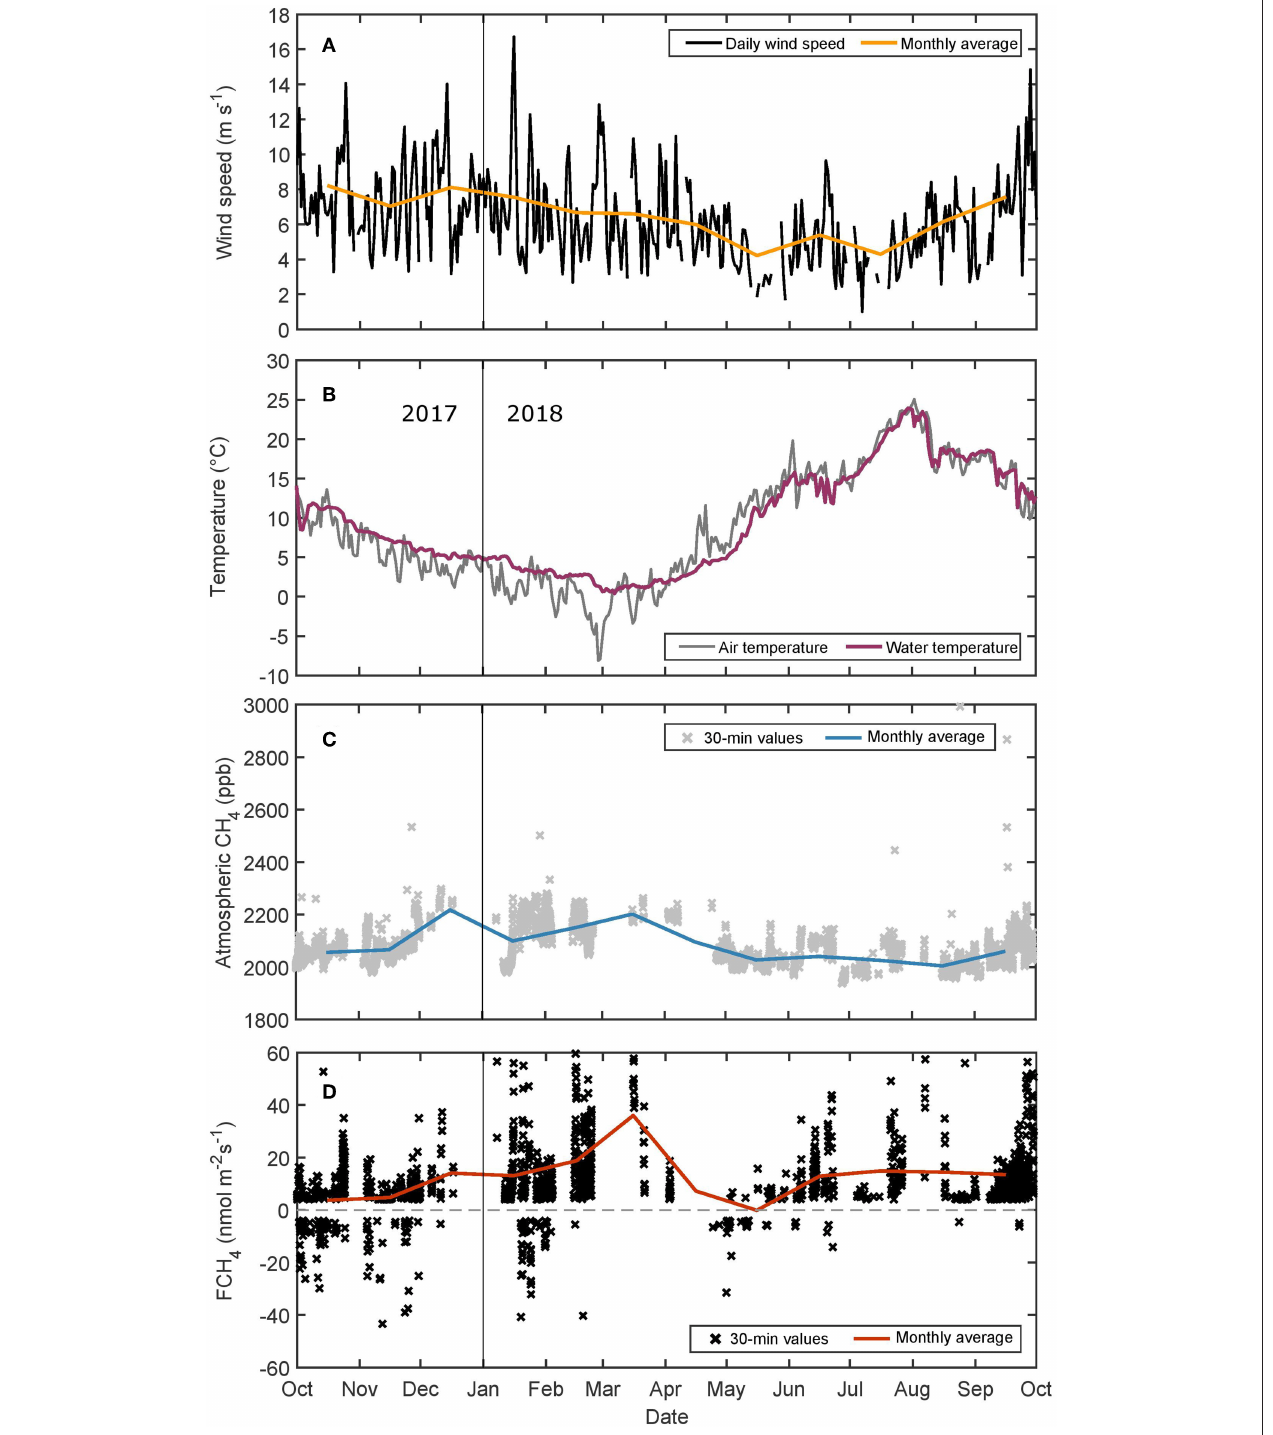
FIGURE 3 | Annual cycle of (A) wind speed, (B) daily averages of air and water temperature, (C) 30-min and monthly averages of atmospheric CH 4 dry mole fraction, and (D) 30-min and monthly averages of air–sea FCH 4 .